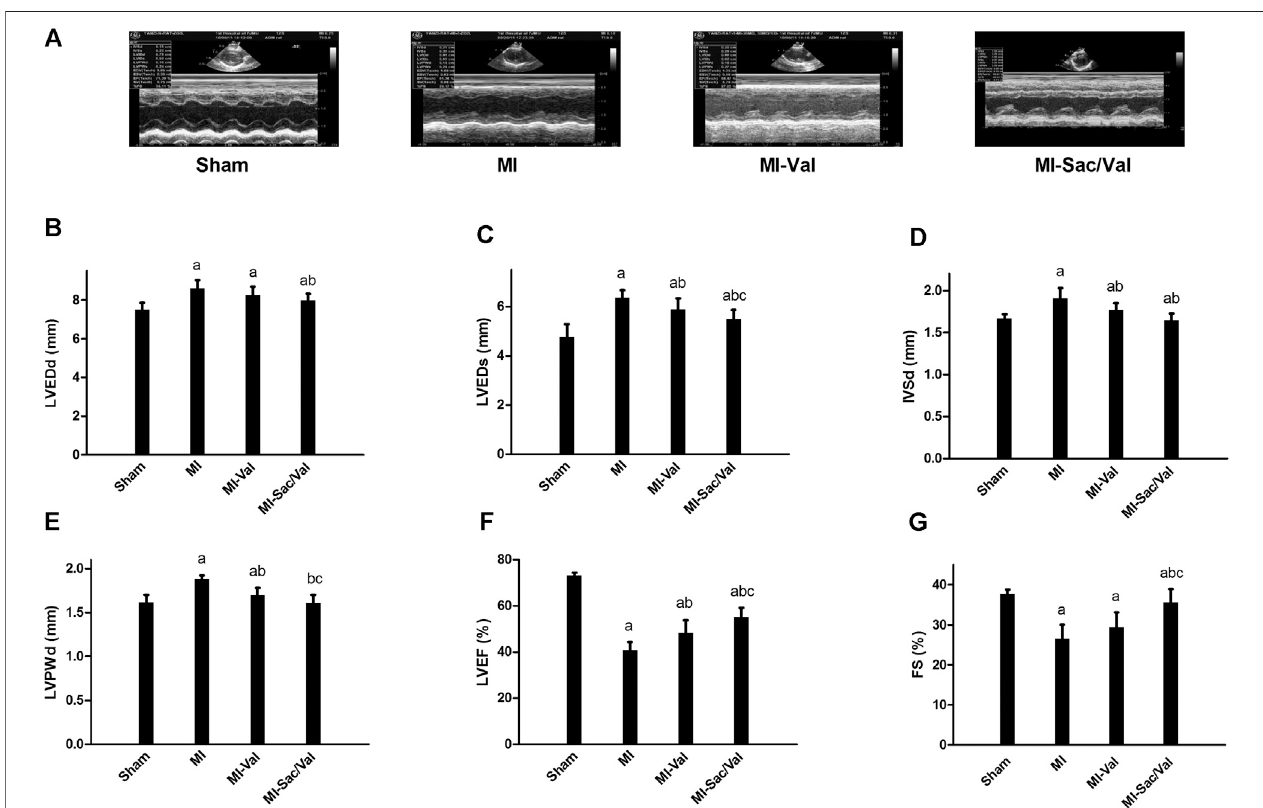
FIGURE 1 | Effects of sacubitril/valsartan on cardiac structure and function determined by echocardiogary in rats with experimental MI. (A) Representative images of M-mode echocardiography. (B – G) Quantitative measurement of echocardiographic parameters. LVEDd, left ventricular end-diastolic dimension; LVEDs, left ventricular end-systolic dimension; IVSd, interventricular septal thickness in diastole; LVPWd, left ventricular posterior wall thickness in diastole; LVEF, left ventricular ejectionfraction;FS,fractional shortening;MI,myocardialinfaction; Val,valsartan;Sac/Val, sacubitril/valsartan.Results aremean ± SD( n (cid:1) 8);a P < 0.05 vs. Sham; b P < 0.05 vs. MI; c P < 0.05 vs.